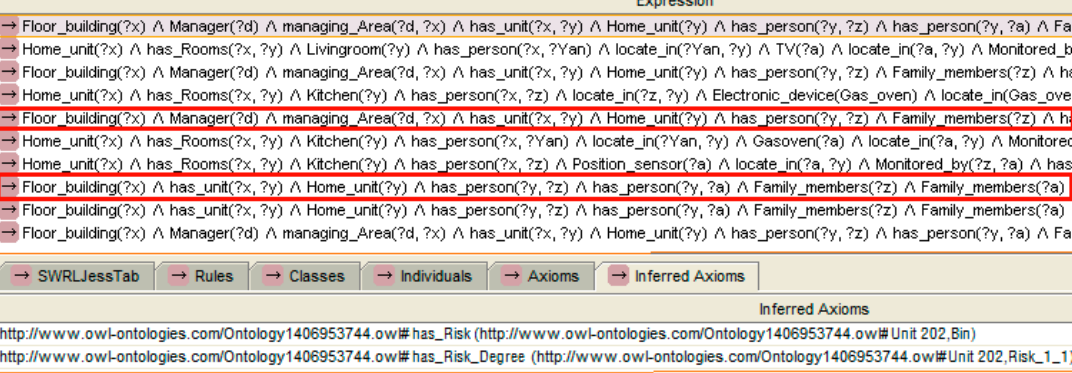
Figure 20. The rule selected and the reasoning result of the first risk.